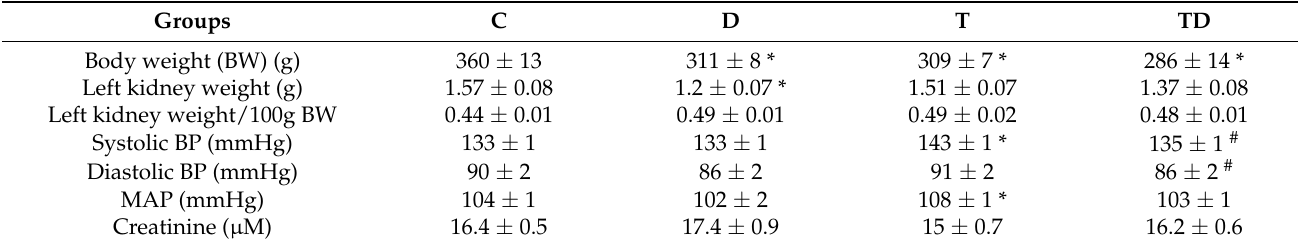
Table 2. Weight, renal function, and blood pressures.